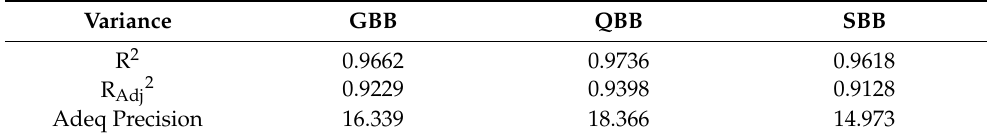
Table 7. Analysis of variance of the regression equation for cadmium ion adsorption by three